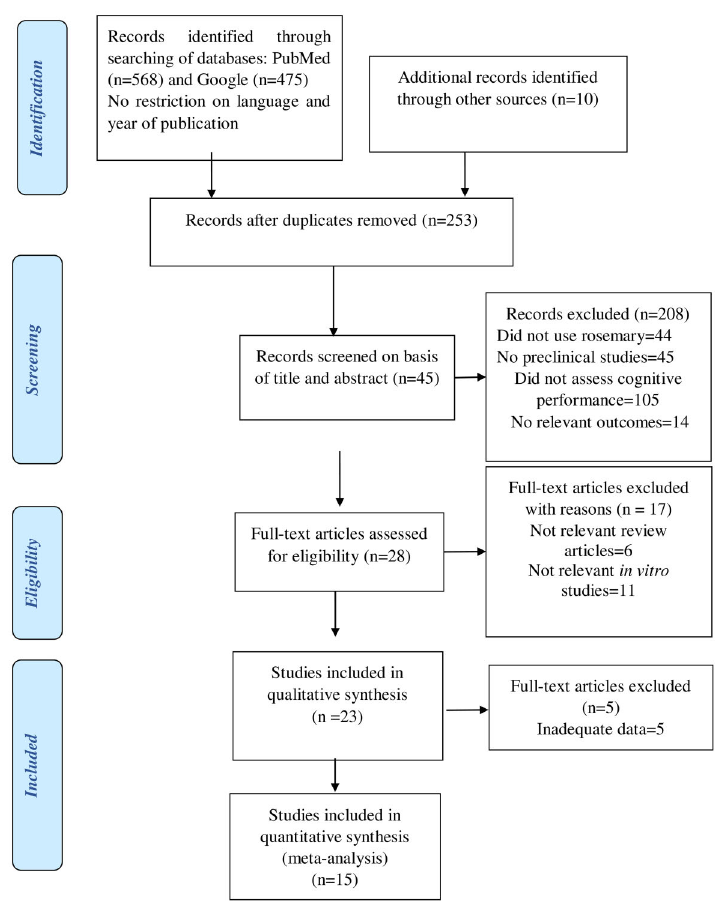
Figure 2. Flow chart of study selection process. The number of studies in each phase is indicated within